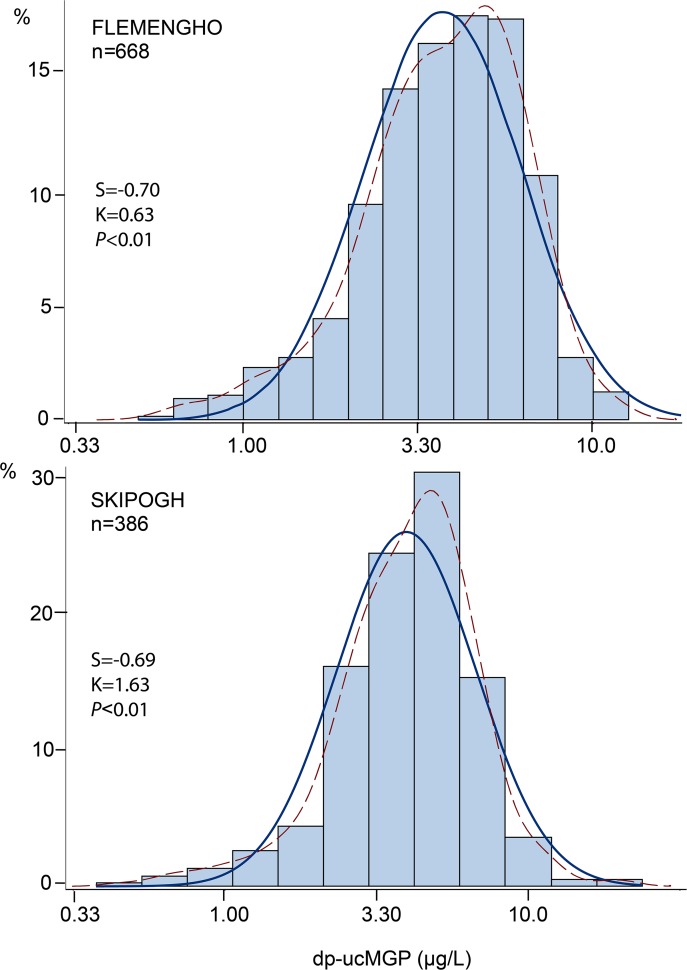
Frequency distributions of dp-ucMGP in Flemish and Swiss.S and K are the coefficients of skewness and kurtosis. The P value is for departure of the actually observed logarithmically transformed distribution (kernel distribution; dotted line) from normality (full line). The geometric mean concentration was 3.94 μg/L in Flemish and 4.20 μg/L in Swiss (P = 0.056).